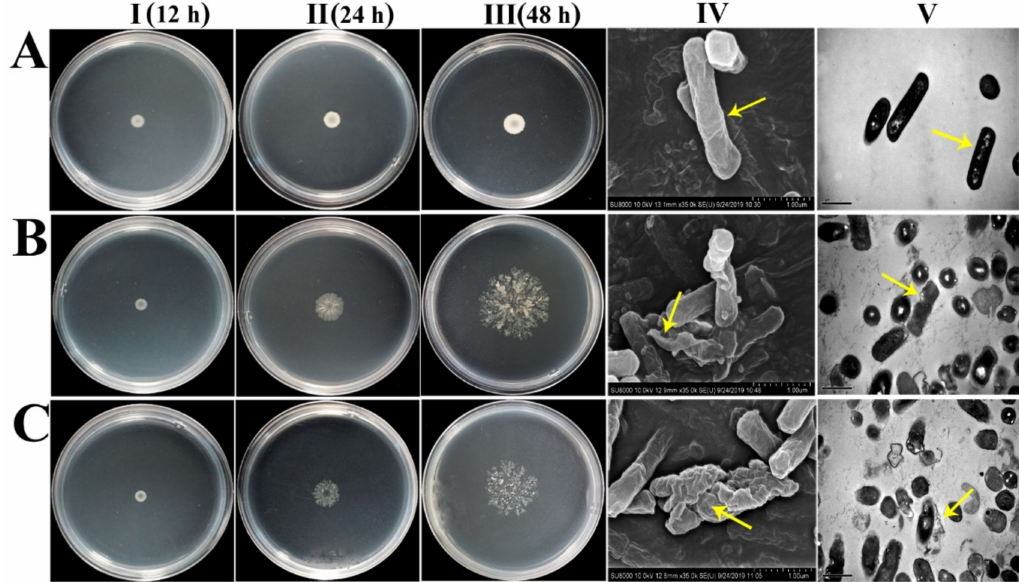
Figure 1. The harmful impacts of antimicrobial gene expression on host cells of B. subtilis . The autolytic strains ( OrR214 and OrR935 ) were placed on Luria-Bertani (LB) plates within 12 to 48 h with the B. subtilis SCK6-e strain and then incubated at 37 ◦ C to observe the morphological changes. ( A - I ) B. subtilis SCK6-e strain, ( B - I ) OrR935 and ( C - I ) OrR214 grew normally within 12 h, and ( A - II ) B. subtilis SCK6-e strain, ( B - II ) OrR935 , and ( C - II ) OrR214 grew after 24 h of incubation, while ( A - III ) B. subtilis SCK6-e strain, ( B - III ) OrR935 , and ( C - III ) OrR214 grew after 48 h of incubation. ( B ) ( OrR935 ) and ( C ) ( OrR214 ) show obvious autolysis and outward di ff usion. The samples were freeze-dried with glutaraldehyde and then coated with gold, and ( A - IV ) B. subtilis SCK6-e strain, ( B - IV ) OrR935 , and ( C - IV ) OrR214 were examined under a scanning electron microscope, and ( A - V ) B. subtilis SCK6-e strain, ( B - V ) OrR935 , and ( C - V ) ( OrR214 ) were examined under a transmission electron microscope. As a control, the B. subtilis empty vector strain (SCK6-e) was used. The scale bar represents 1 µ